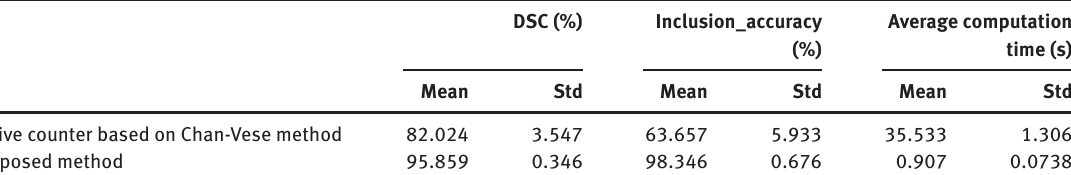
Table 2: Comparison